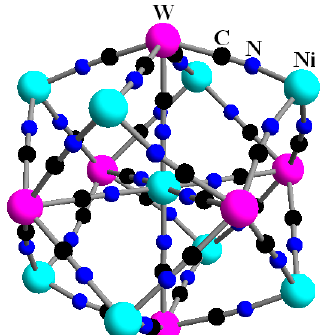
Figure 1. Core of the Ni 9 W 6 clusters: W—magenta; Ni—cyan; N—blue; C—black. The relative sizes of the balls correspond to the atomic radii of the respective atoms.